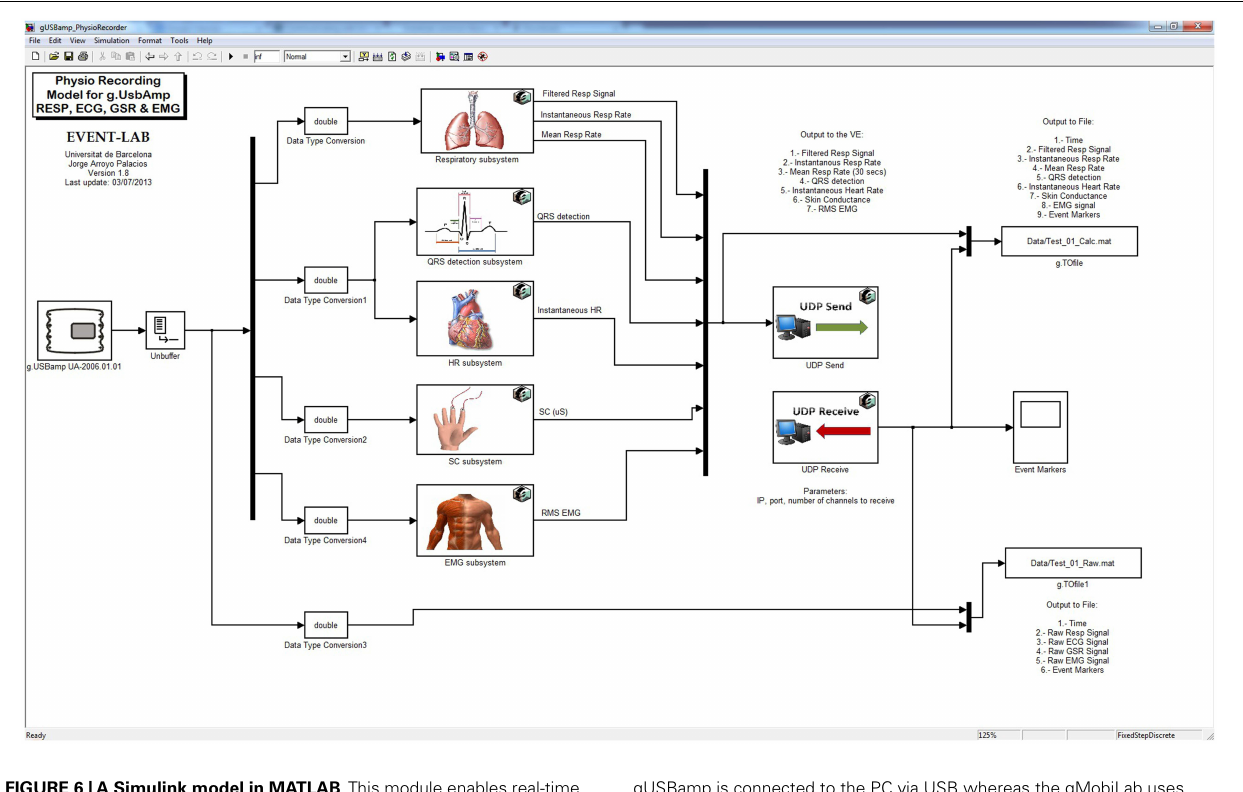
FIGURE 6 |A Simulink model in MATLAB .This module enables real-time recording and processing of physiological data withinVEs.This can handle respiratory, cardiovascular, electro-dermal and electromyography measurements using the gUSBamp or the gMobilab devices from gtec.